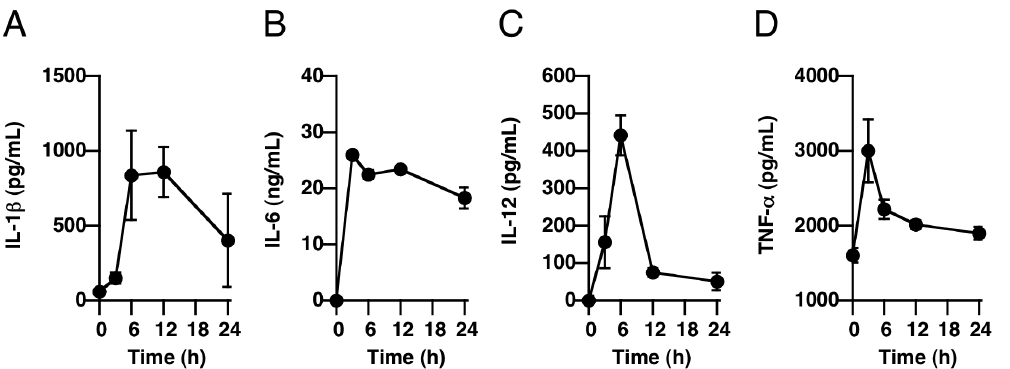
Figure 7. LPS treatment induced increased serum levels of cytokines. ( A – D ) Male C57BL/6 mice at 6 weeks of age were given LPS (400 m g/ head i.p.), and blood samples were collected at 3, 6, 12, and 24 h after LPS injection. Serum levels of IL-1ß, IL-6, IL-12 and TNF-alpha were determined as described in Materials and Methods .